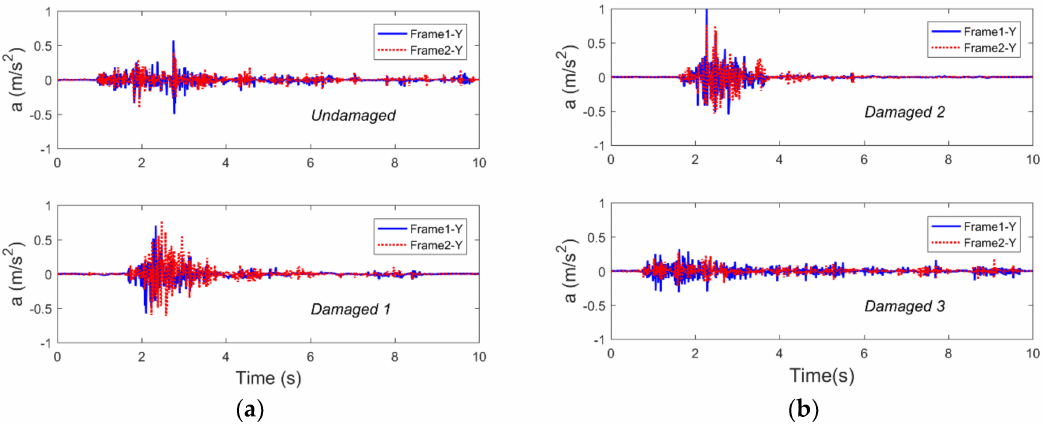
Figure 6. The Y-axis acceleration time-history responses as collected by smartphones subjected to Nr-1 cm are shown ( a ) in the undamaged and damaged 1 cases and ( b ) in the damaged 2 and 3